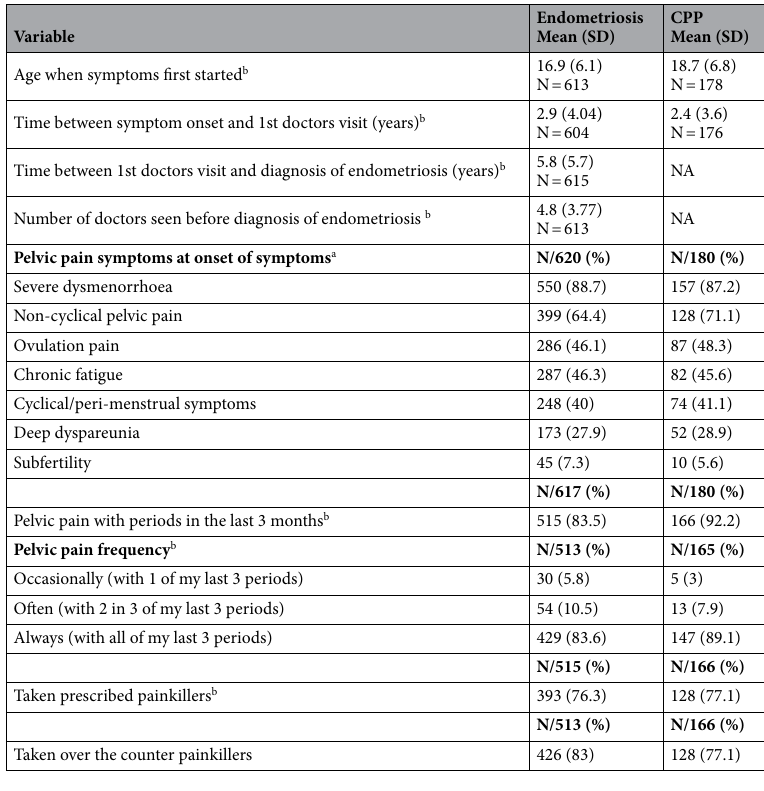
Table 2. Diagnostic delay and pelvic pain symptoms. a Respondents were able to select more than one option. b Respondents were not required to answer all question fields in the